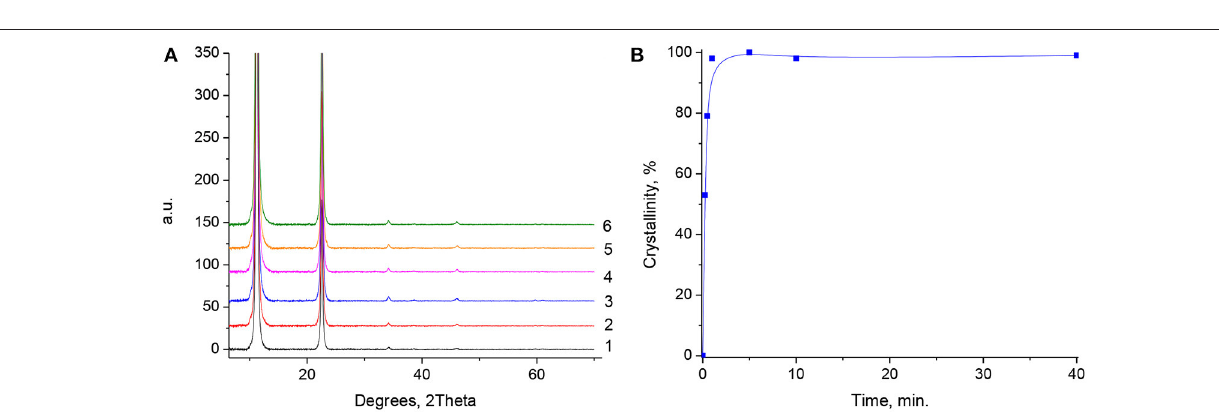
Frontiers in Chemistry |